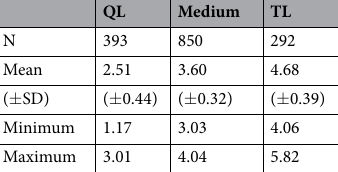
Table 1. Pinctada margaritifera juvenile (N = 1535) shell diameter summary data. Values below 3 cm correspond to the QL phenotype group (n = 393) and values above 4 cm correspond to the TL phenotype group (n =